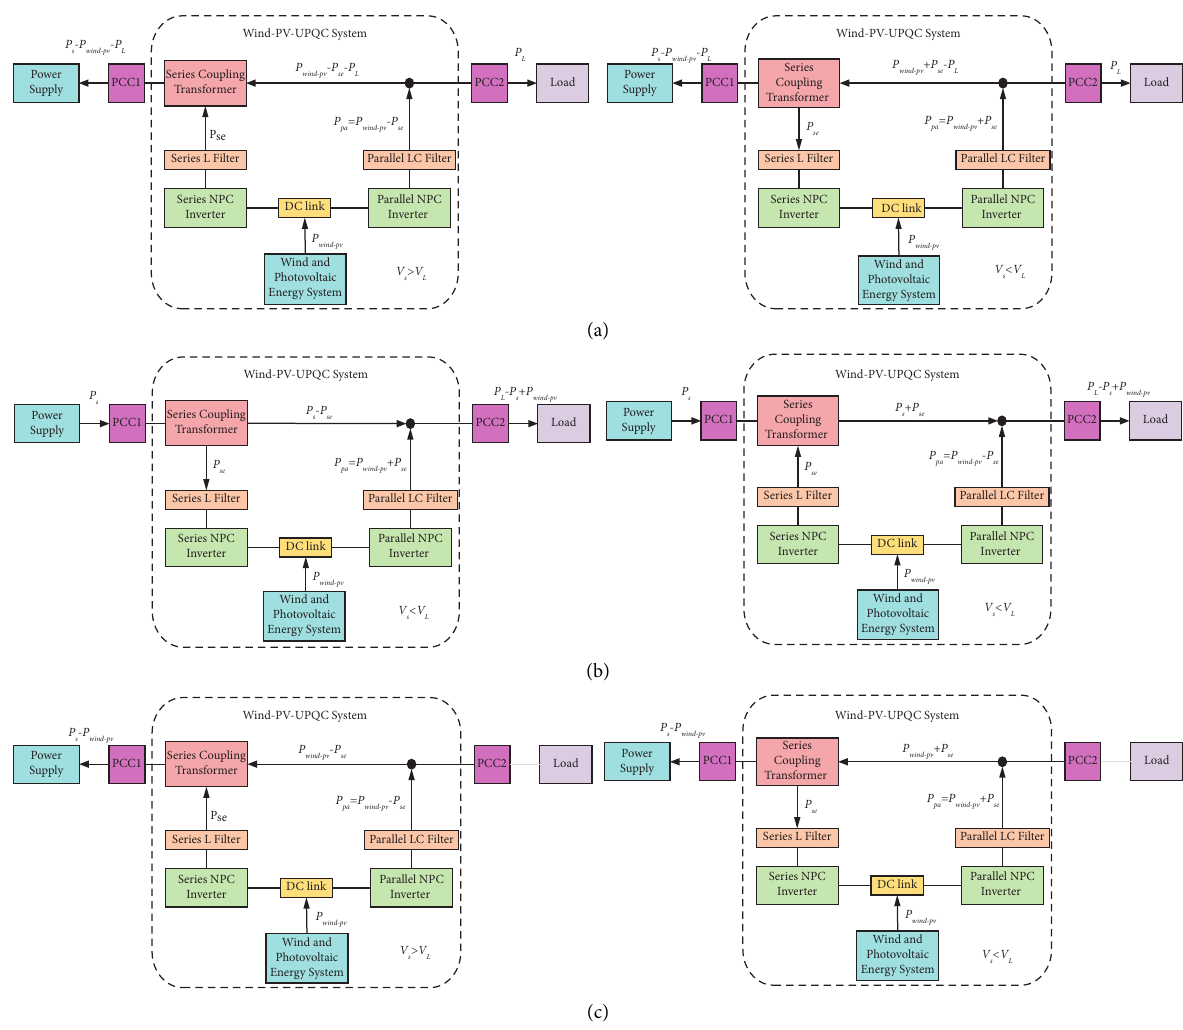
Figure 3: Flow of active power by the system of Wind-PV-UPQC. (a) P